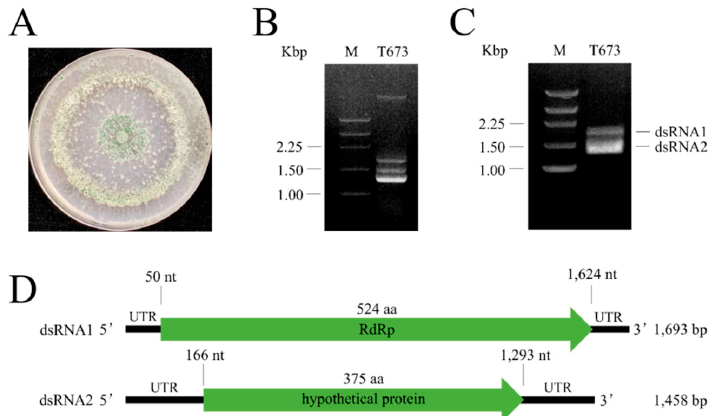
Figure 1. Identification of a dsRNA partitivirus in T. harzianum strain T673 and proposed genomic organization of the mycovirus. ( A ). Colony morphology of strain T673. ( B ). DsRNA extracted from strain T673. M: 250 bp DNA Ladder (TaKaRa, Kusatsu, Shiga, Japan); T673: dsRNAs from strain T673. ( C ). S1 nuclease- and DNase Ι -treated dsRNA from strain T673. M: 250 bp DNA ladder; T673. ( D ). Proposed genome organization of dsRNAs 1 and 2. ORFs are indicated as green arrows.